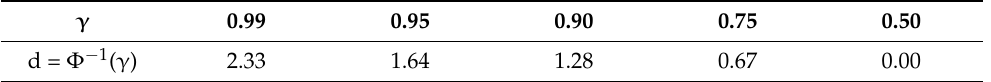
Table 4. Values of d parameter for various levels of confidence γ (for example for captive guiding).